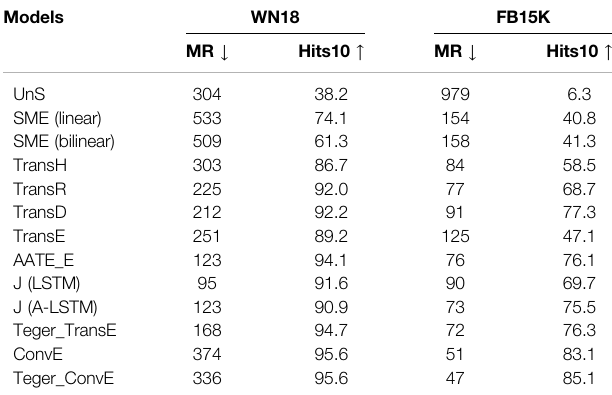
TABLE 1 | Statistics of the datasets. Dataset